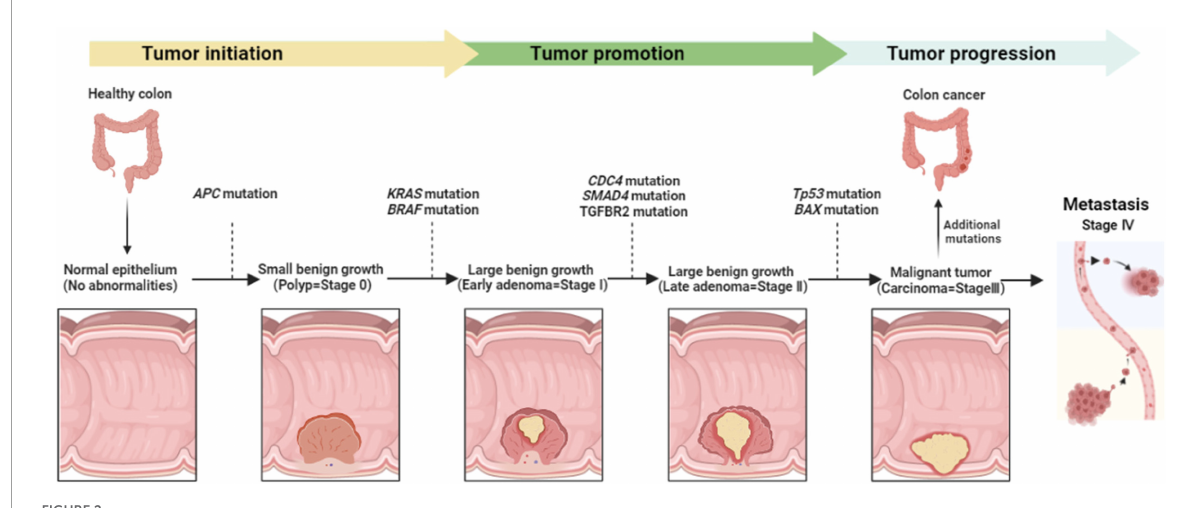
FIGURE2 Colorectal cancer development, stages, and the main genetic modifications all along tumor progression.